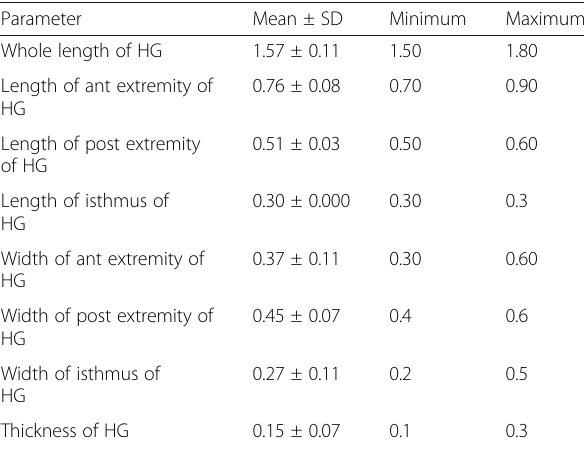
Table 2 Descriptive statistics of different dimensions (cm)